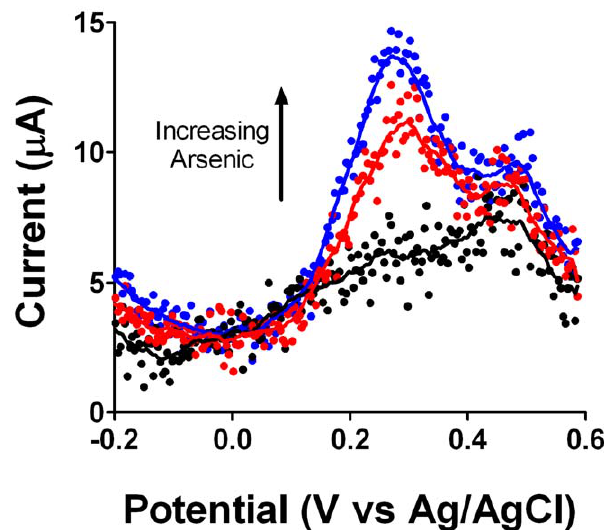
Figure 5. Analysis of the arsenic content in three acidified lake water solutions. Samples were collected from Lake Cachuma (Santa Barbara, CA) and mixed in an 11:1 ratio with concentrated HCl. An arsenate standard was spiked into two of the samples (top 20 ppb, middle 5 ppb), and one was left as a blank (bottom). The dissolved arsenate in each solution was reduced at 2 0.5 V and then analyzed by square wave voltammetry at 40 Hz.